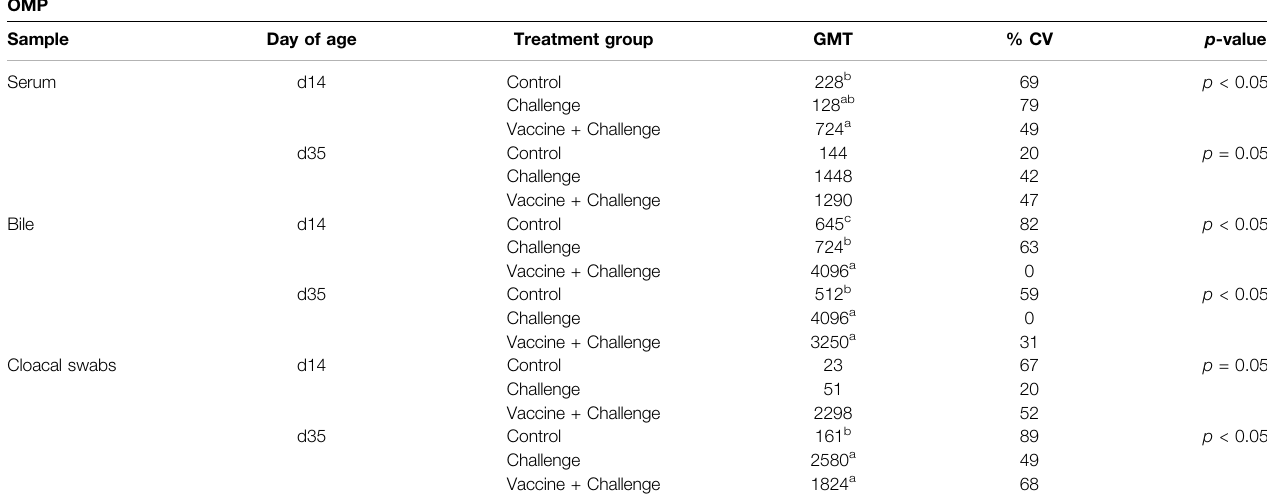
TABLE 6 | The GMT of anti- S. Enteritidis OMP IgY and IgA antibodies. Blood, bile, and cloacal swabs samples were collected at d14 of age (pre-challenge) and d35 of age (post-challenge). Samples were analyzed for anti- Salmonella OMP IgY and OMP IgA levels by ELISA ( n = 6). Results were reported as geometric mean titers (GMT). Values with no common superscript differ ( p < 0.05). The percent increase was determined as [(GMT of Vaccine + Challenge) – (GMT of Control)] ÷ (GMT of Control) × 100.